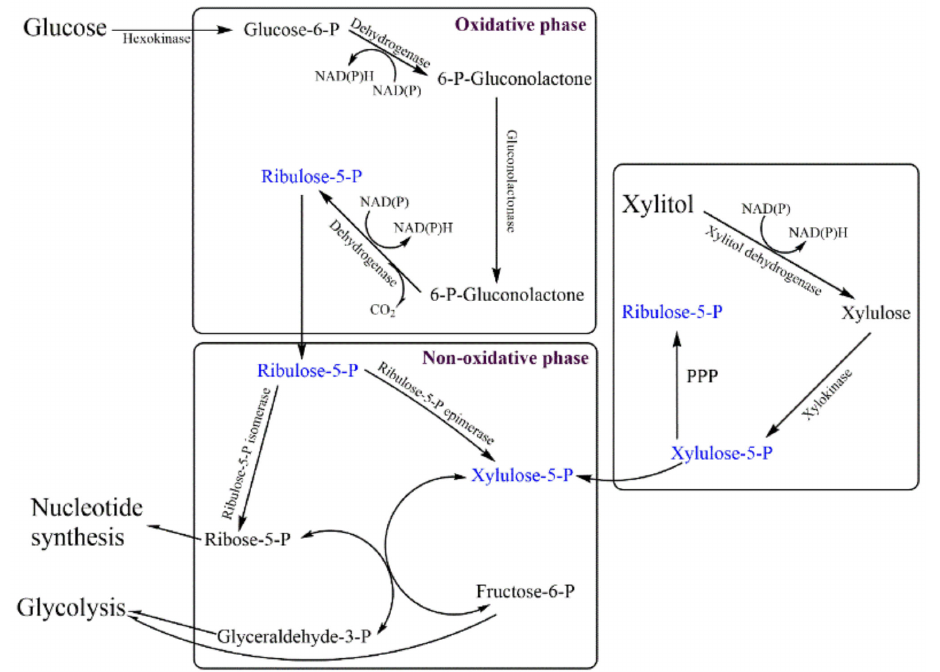
Figure 5. Compensation of NADPH deficiency from xylitol metabolism by Hexose monophosphate to counter oxidative stress in glucose-6-phosphate deficiency induced hemolytic anemia. Due to